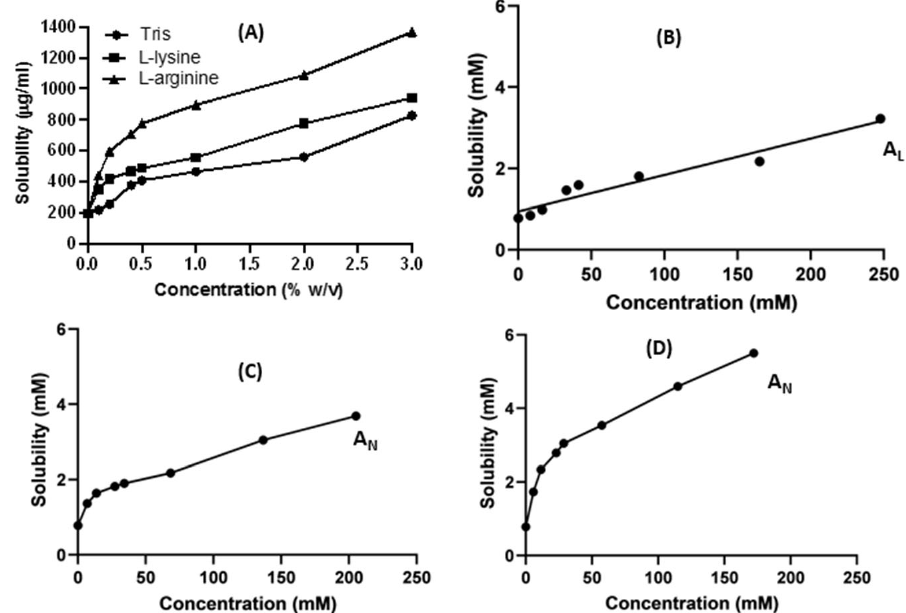
Figure 2. ( A ) Solubility curves μ g/mL versus concentration of the three basic excipients (% w/v ). Phase solubility curves (mM) versus concentrations of the three basic excipients (mM): ( B ) tris, ( C ) L ‐ lysine, and ( D ) L ‐ arginine.